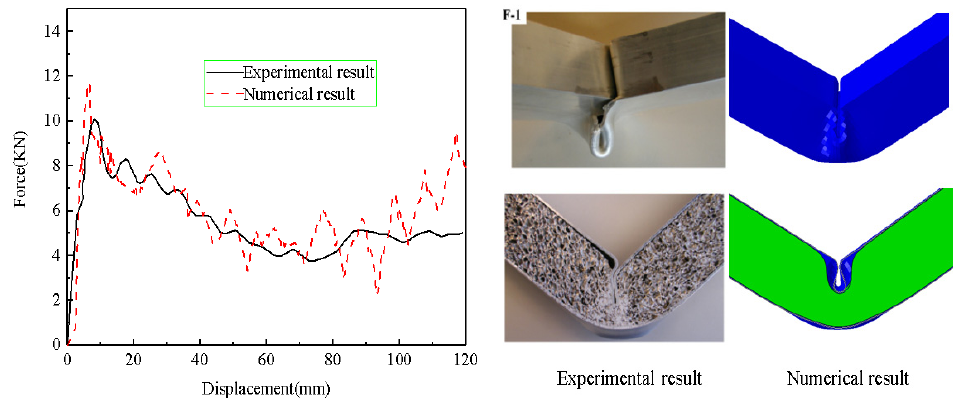
Figure 4. Comparison of test results and numerical results.